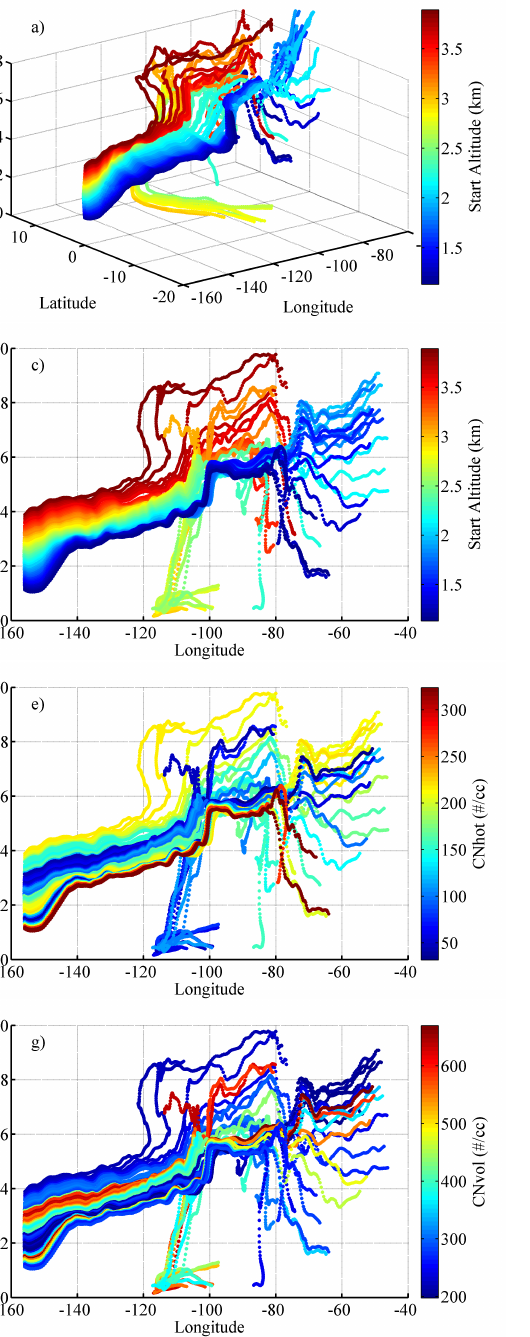
Fig. 9: As Figure 6 but for Case Study II around 21:30 UTC during research flight 14 on 6 September. Fig. 9. As Fig. 6 but for case study II around 21:30UTC during research flight 14 on 6 September. For the remaining five layers below the stratospheric fea- 1160 cumulated precipitation illustrated in plot d is increased for For the remaining five layers below the stratospheric fea- cluster-visualization approach. Instead of analyzing trajecto- ture it is not clear immediately which of these layers is a three of the five layers. Hence, we will try to use the conjunc- ture it is not immediately clear which of these layers is a ries utilizing in situ data as done for the first case study, we pollution feature or an ITCZ cloud outflow layer because ac- tion of in-situ measurements and trajectory information in 1165 pollution feature or an ITCZ cloud outflow layer because ac- assume the modeled pathways to be correct for now and try cumulated precipitation illustrated in plot d is increased for to interpret in situ observations based on this assumption and three of the five layers. Hence, we will try to use the conjunc- then examine any inconsistencies over the tion of in situ measurements and trajectory information in our